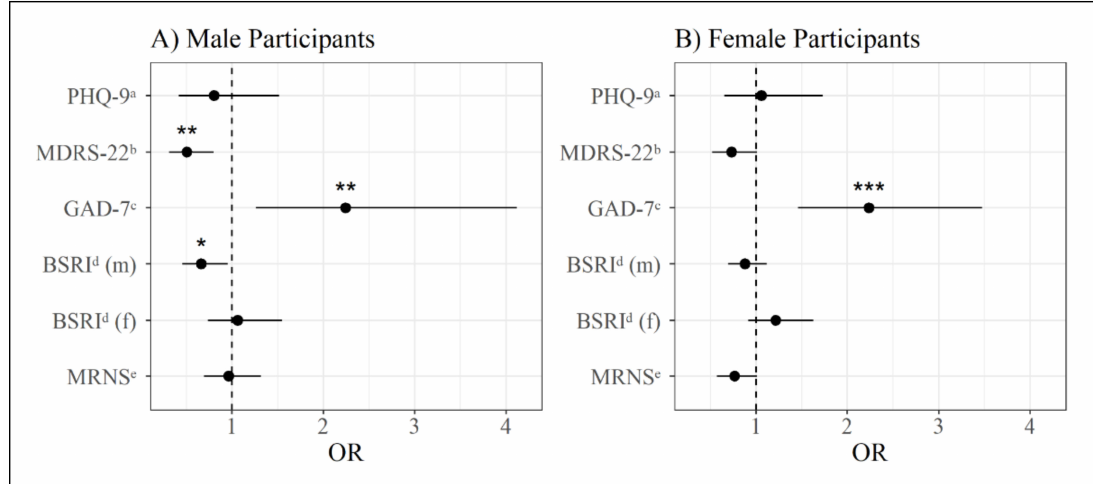
Figure 4. Odds ratios for psychotherapy use based on the questionnaires with a 95% confidence interval. ( A ) Male Partici- pants; ( B ) Female Participants. Note: m = masculine subscale, f = feminine subscale, OR = odds ratio. a PHQ-9 = Patient Health Questionnaire-9; b MDRS-22 = Male Depression Risk Scale-22; c GAD-7 = Generalized Anxiety Disorder-7; d BSRI = Bem Sex-Role Inventory; e MRNS = Male Role Norm Scale; * = p < 0.05, ** = p < 0.01, *** = p <